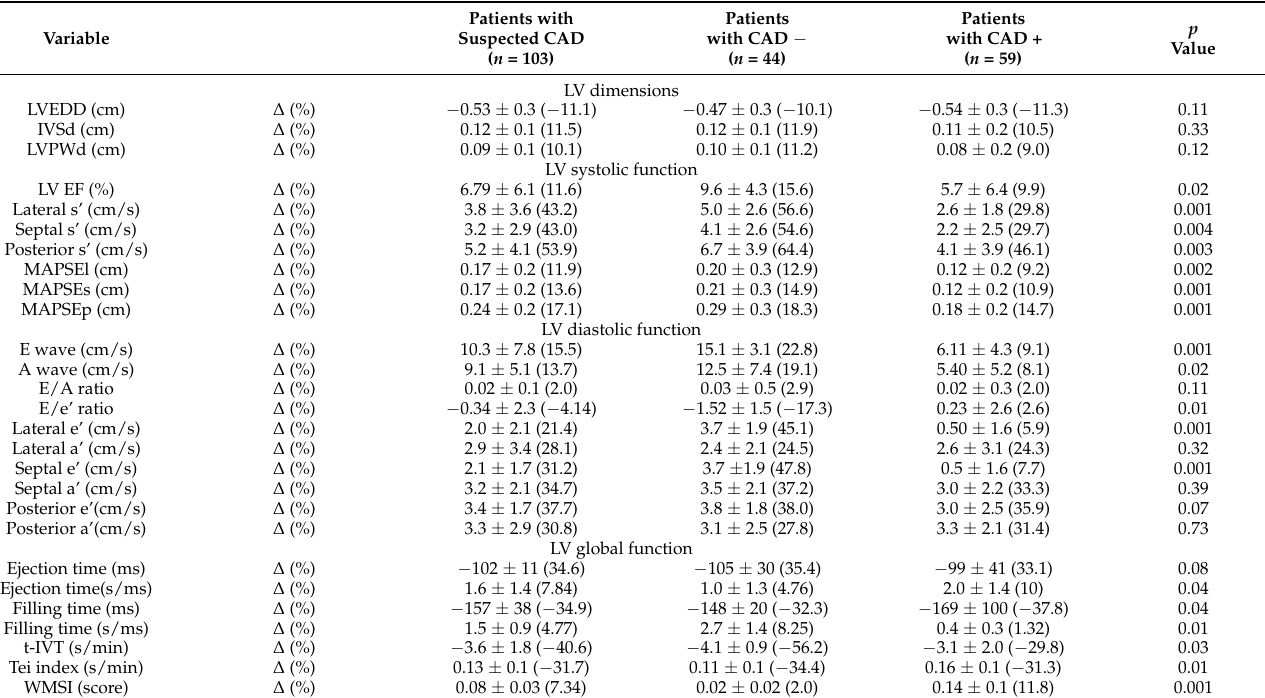
Table 1. Baseline and stress echocardiographic indices in patients with and without CAD. Patients with Suspected